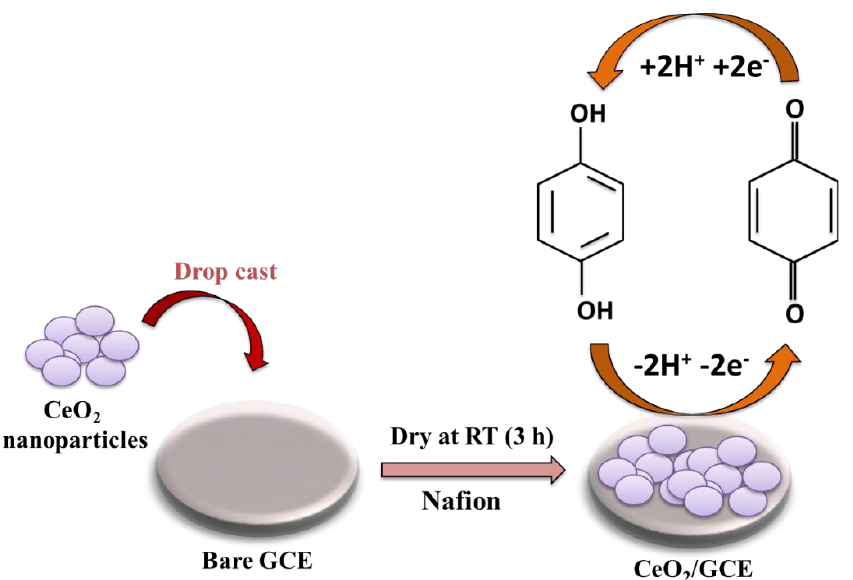
Scheme 2. Schematic picture shows the fabrication and working of CeO 2 /GCE